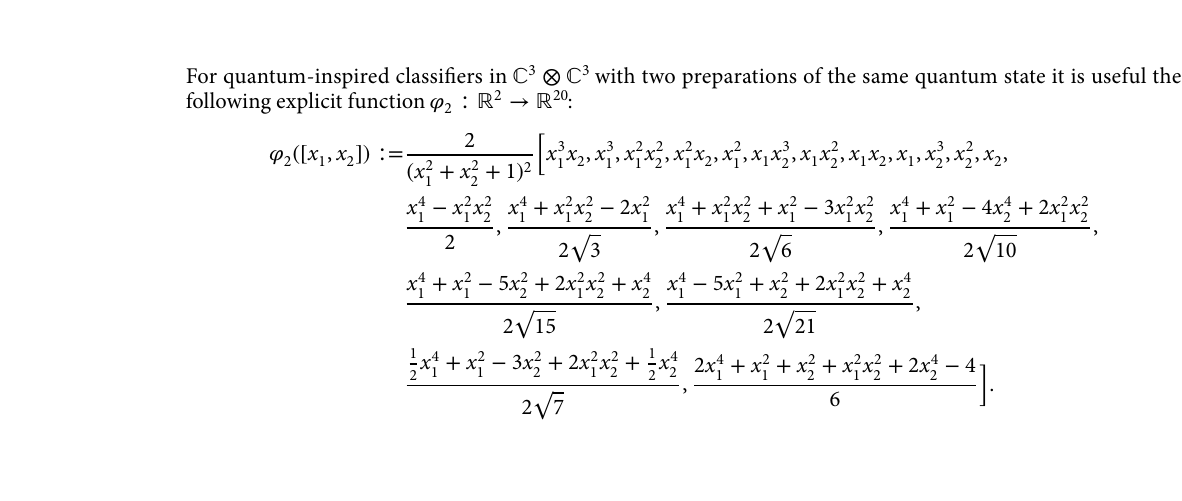
Table 4. Average accuracy with 2 features mapped into high-dimensional feature space ℝ 20